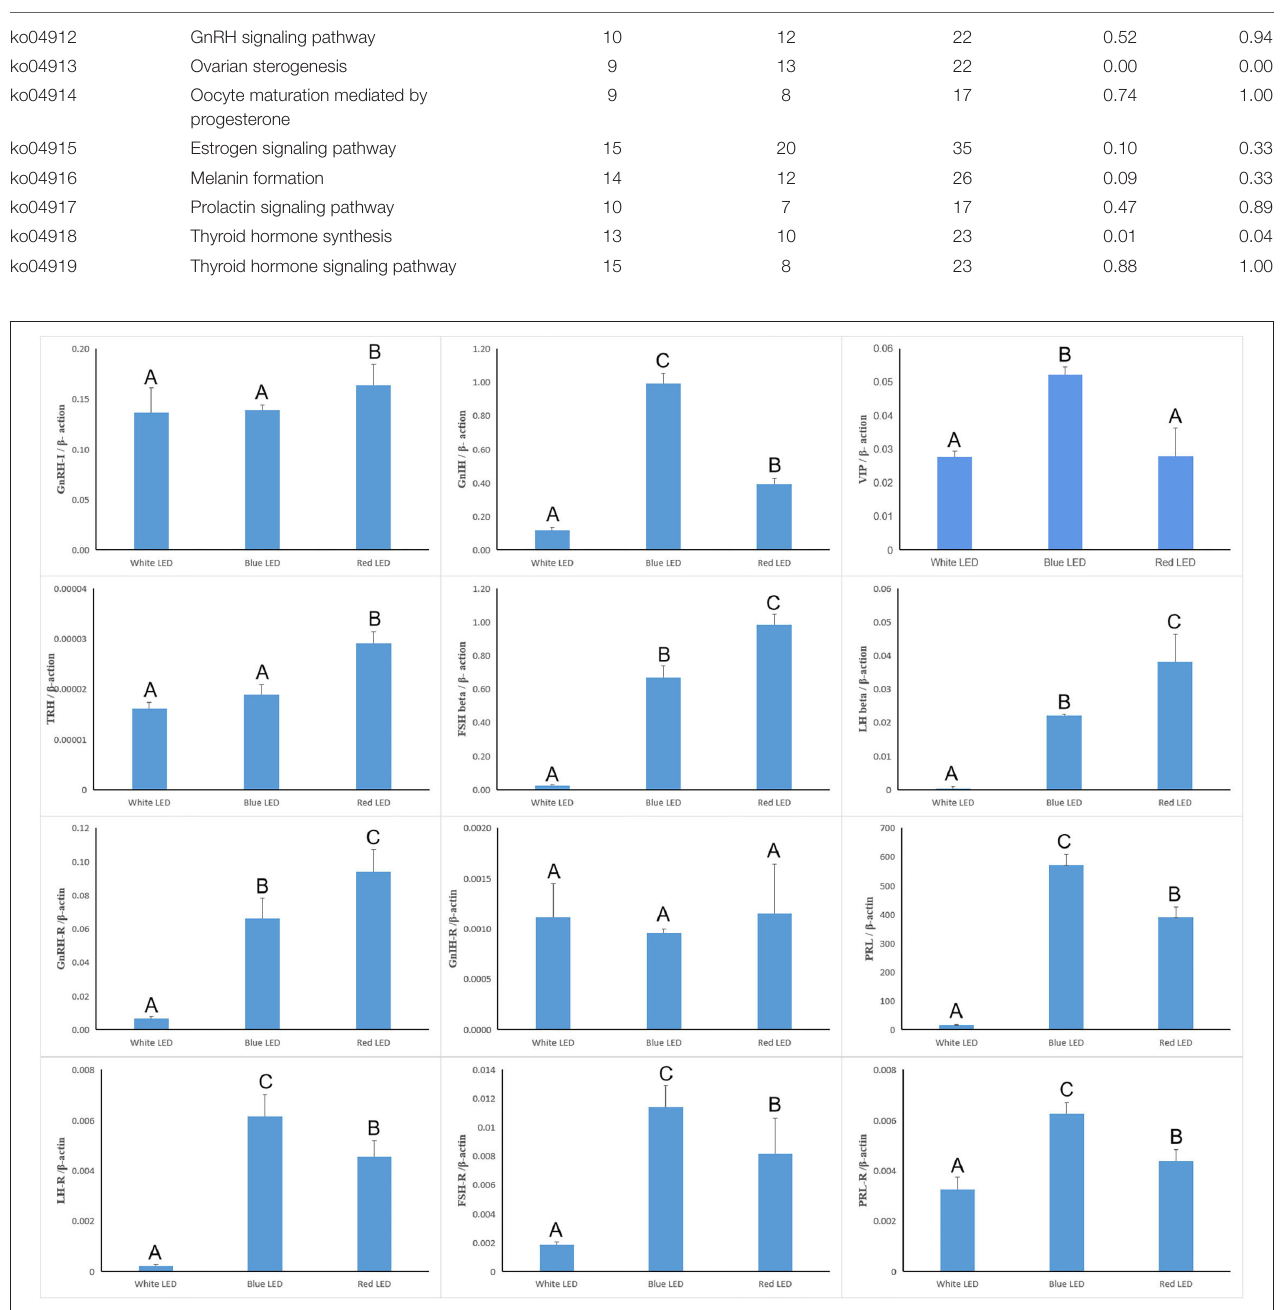
Zi-goose (19, 20). Reddy et al. also found that when treated with red light, group laying performance was the highest, and the LH and GnRH concentration of laying hens was higher than in the blue light group (21). The results showed that blue light could stimulate the secretion of FSH and LH, improve the